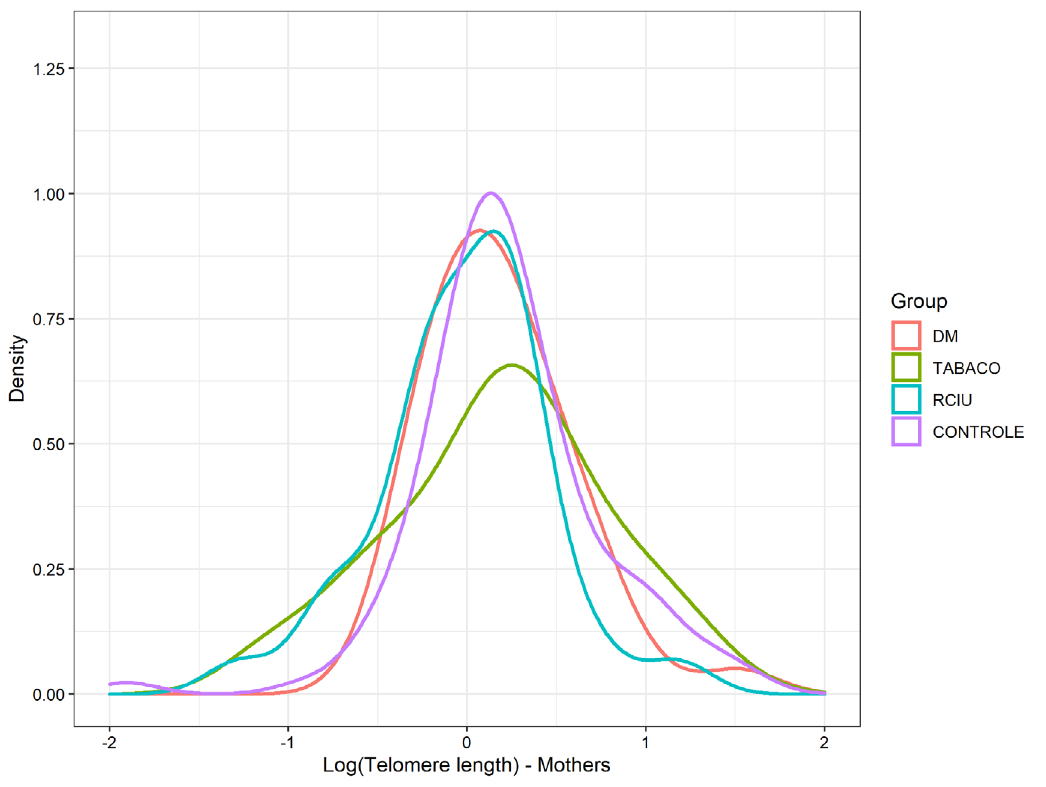
Figure 1 ‒ Telomere length of mothers among groups after adjustment age. p=0 . 191 (data from Table 2). Telomeres presented asymmetric distribution and underwent logarithmic transformation.